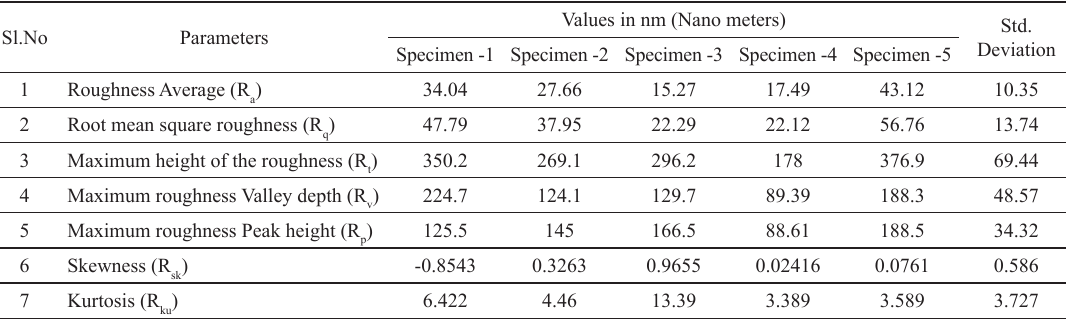
Table 3. Surface texture characteristics for the wear specimens.